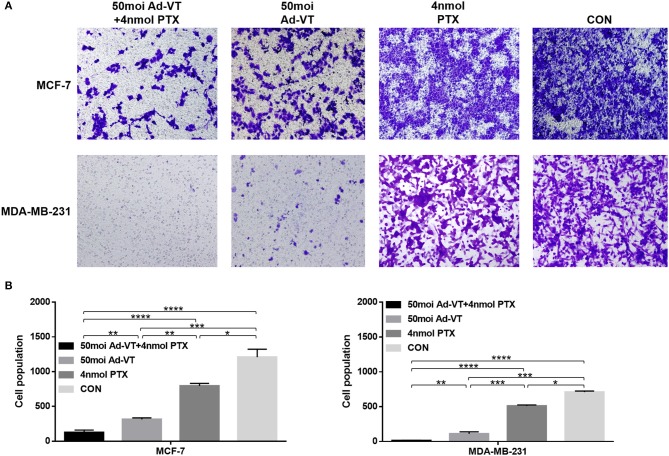
Effects on MCF-7 and MDA-MB-231 cells invasion assessed using the Transwell assay. (A) Suppression of MCF-7 and MDA-MB-231 cells invasion 72 h after treatment with Ad-VT, paclitaxel and Ad-VT and paclitaxel mixture. (B) Cells that passed through the membrane were counted under a microscope after fixation with carbinol and staining with crystal violet. Cells infected with the combination of Ad-VT and paclitaxel, showed the lowest invasion at 72 h. All measurements were performed in triplicate. *p < 0.05, **p < 0.01, ***p < 0.001, ****p < 0.0001.